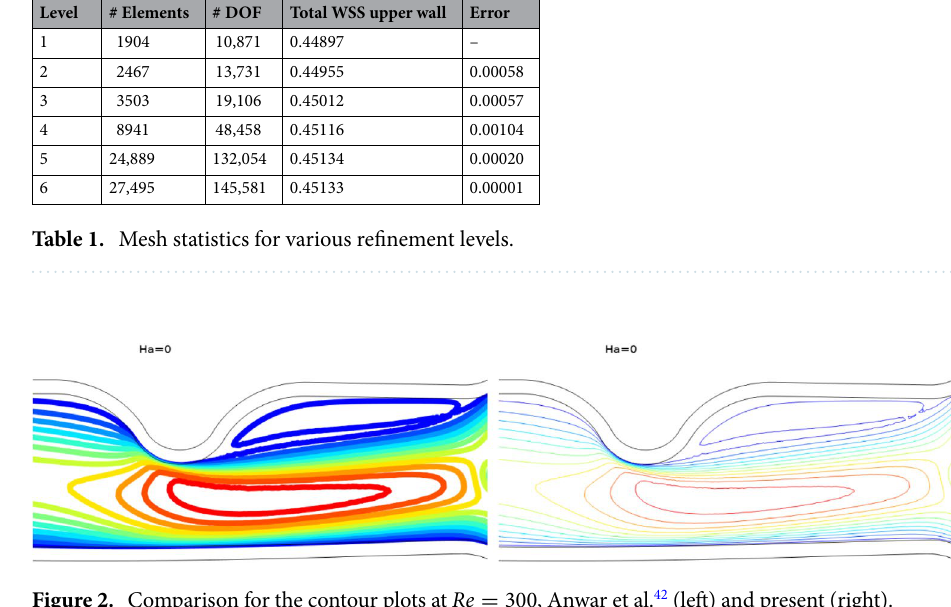
Figure 2. Comparison for the contour plots at Re = 300 , Anwar et al. 42 (left) and present (right).